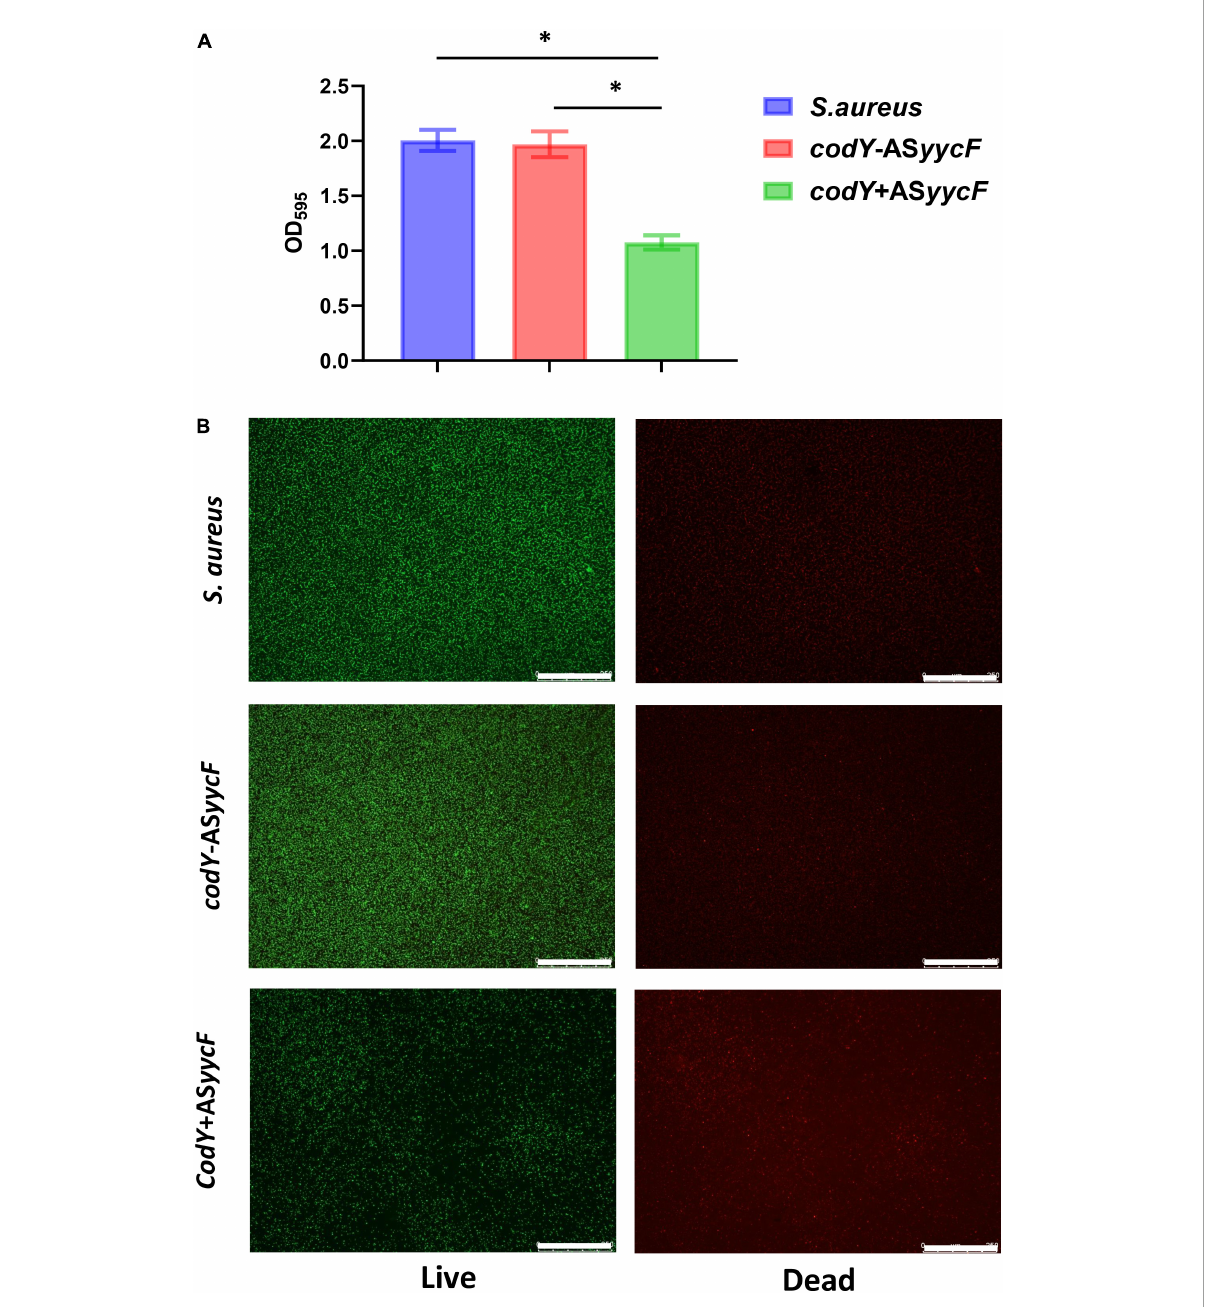
FIGURE3 CodY interaction with yycF regulates the biofilm biomass. (A) Biomass of S. aureus , codY + AS yycF, and codY -AS yycF dual- mutant stains were quantified by crystal violet staining. Optical densities at 595 nm were measured ( n = 5, ∗ P < 0.05). (B) The CLSM observations of S. aureus , codY + AS yycF and codY -AS yycF dual- mutant stains. Green, viable bacteria (SYTO 9); red, dead bacteria (PI); scale bars, 250 µ m.